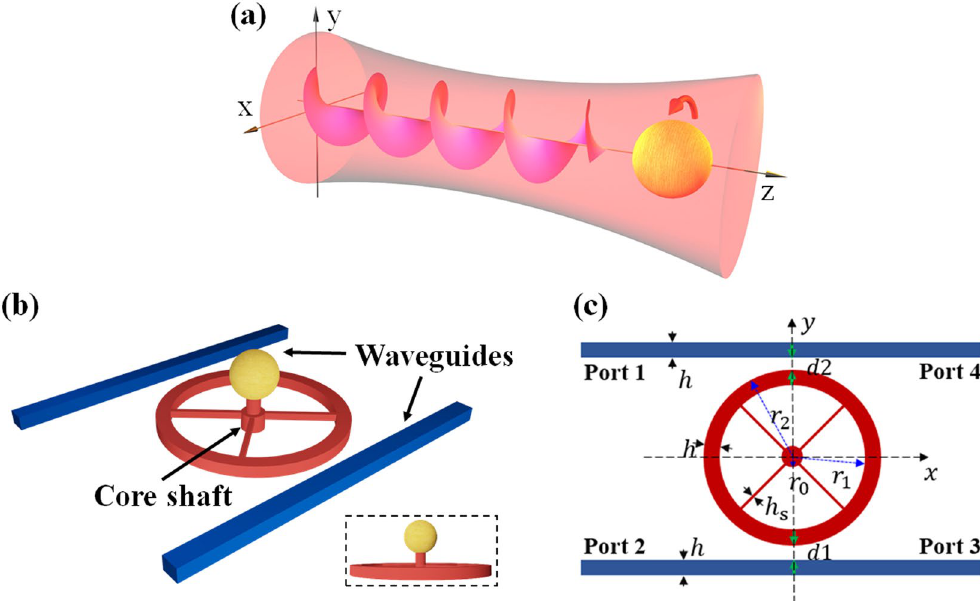
Figure 1. Schematic diagram of the giant and tunable optical torque on an object with the assistance of a ring resonator. ( a ) Traditional optical torque generation on the object by direct illumination with a structured light beam carrying angular or spin momentum. ( b ) Giant optical torque generation on the object by rotating the optical ring resonator (the red part), which mainly includes two parts: the optical part (the ring resonator and two feeding waveguides) and the mechanical part (the target and the connector, i.e., the sphere and the cores shaft, respectively). The ring resonator is feed through two fixed bus waveguides (the blue part) with linear polarization sources. Through the four connecting spokes, the ring resonator can rotate smoothly around the core shaft when driven by the optical torque. Owing to connecting rigidly with the connector (the rigid core shaft), the target (the gold sphere) will rotate synchronously with the connector at the same angular velocity. Suppose the bus waveguides, motor resonator, spokes and shaft are all made of silicon (refractive index of 3.4). ( c ) Two dimensional (2D) projection of the structure on the xy -plane, which is used in the numerical investigation of this paper. The ring resonator and the core shaft both centered at the coordination origin of (0,0). The parameters used in the simulations are r 0 = 320 nm, r 1 = 2.2 μ m, r 2 = 2.4 μ m, h = 0.2 μ m, h s = 54 nm, d 1 and d 2 are the separation between the waveguides and ring d 1 + d 2 = 0.4 μ m. With these parameters, the resonant wavelength of the ring resonator is near the communication wavelength 1550